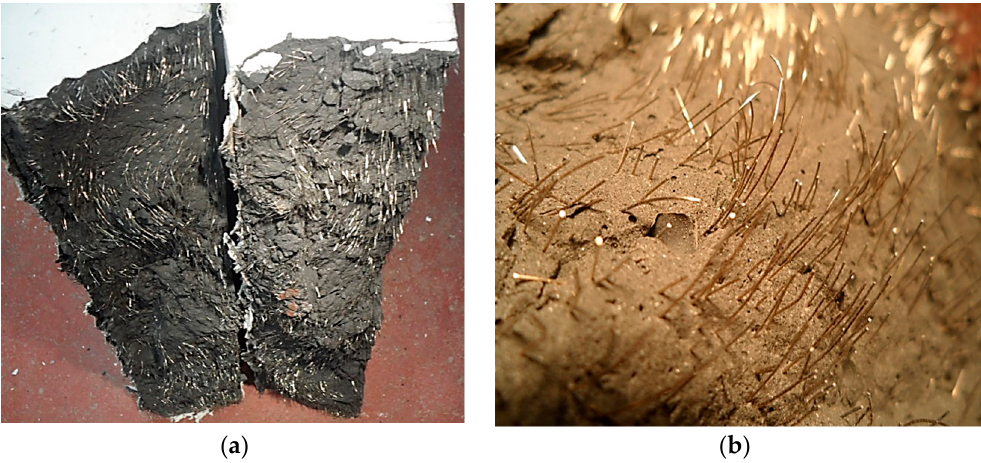
Figure 9. Failure of UHPC segments: ( a ) Segment broke into two pieces; ( b ) Fibers pulled out from the matrix.